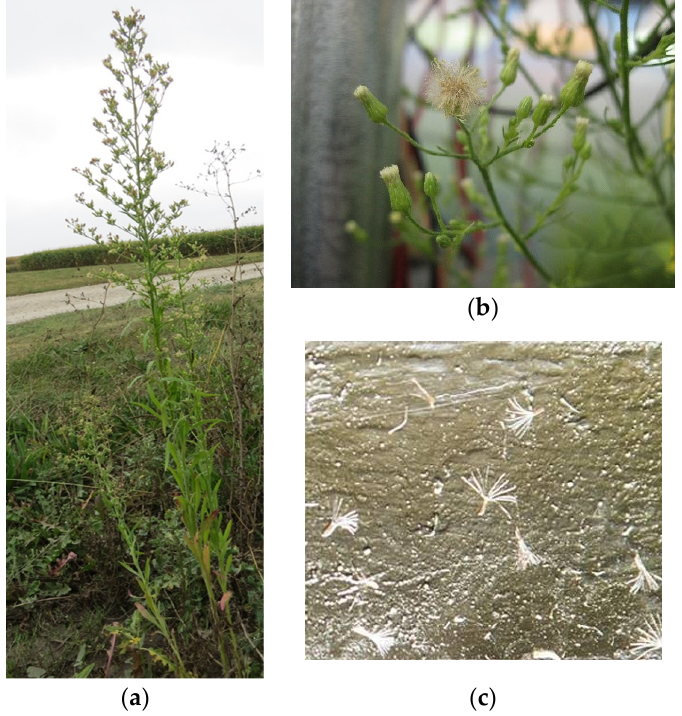
Figure 1. Structure of horseweed plants. ( a ) Mature horseweed plants; ( b ) Flowers of horseweed plant; ( c ) Horseweed seeds in a microscopic field.